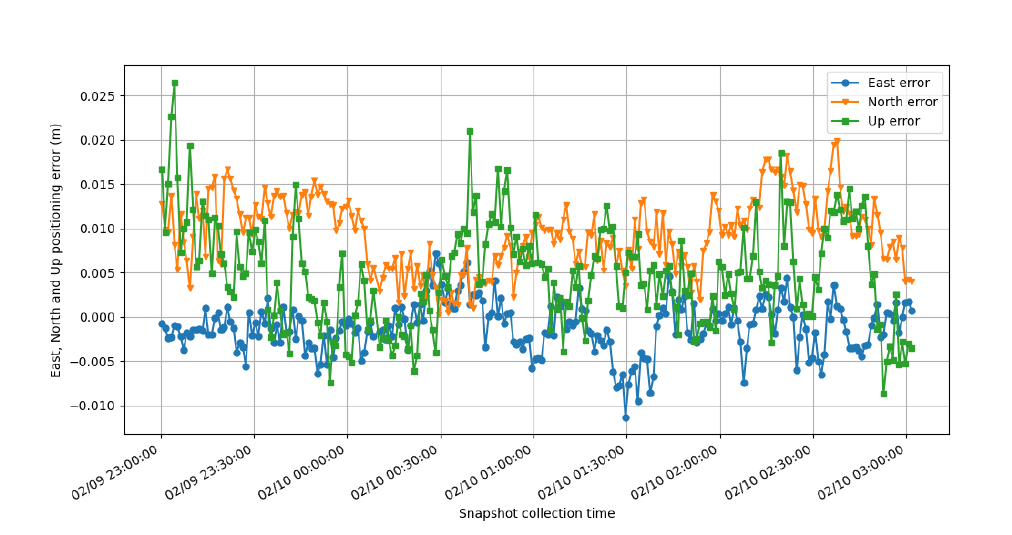
Figure 11. East (blue), North (orange) and Up (green) errors of SRTK fixed solutions under 5 km baseline.